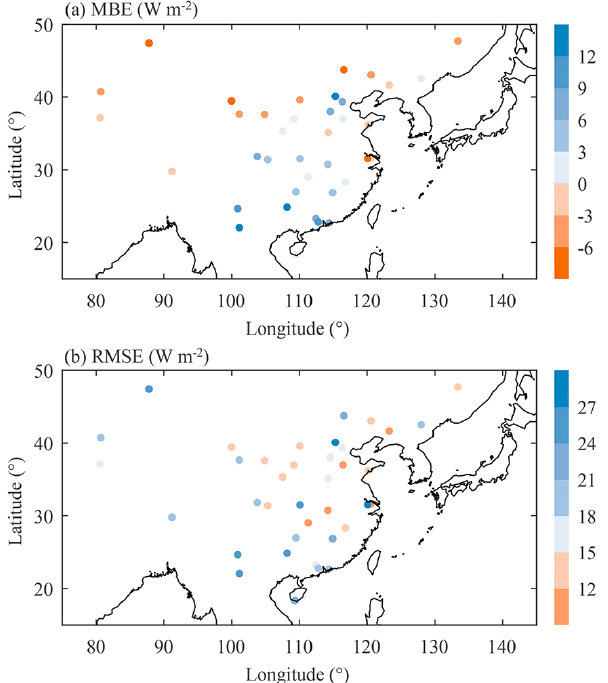
Figure 9. Spatial distribution of (a) MBE (Wm − 2 ) and (b) RMSE (Wm − 2 ) for our estimated daily PAR product (ISCCP-ITP, 30km) at 38 CERN stations.